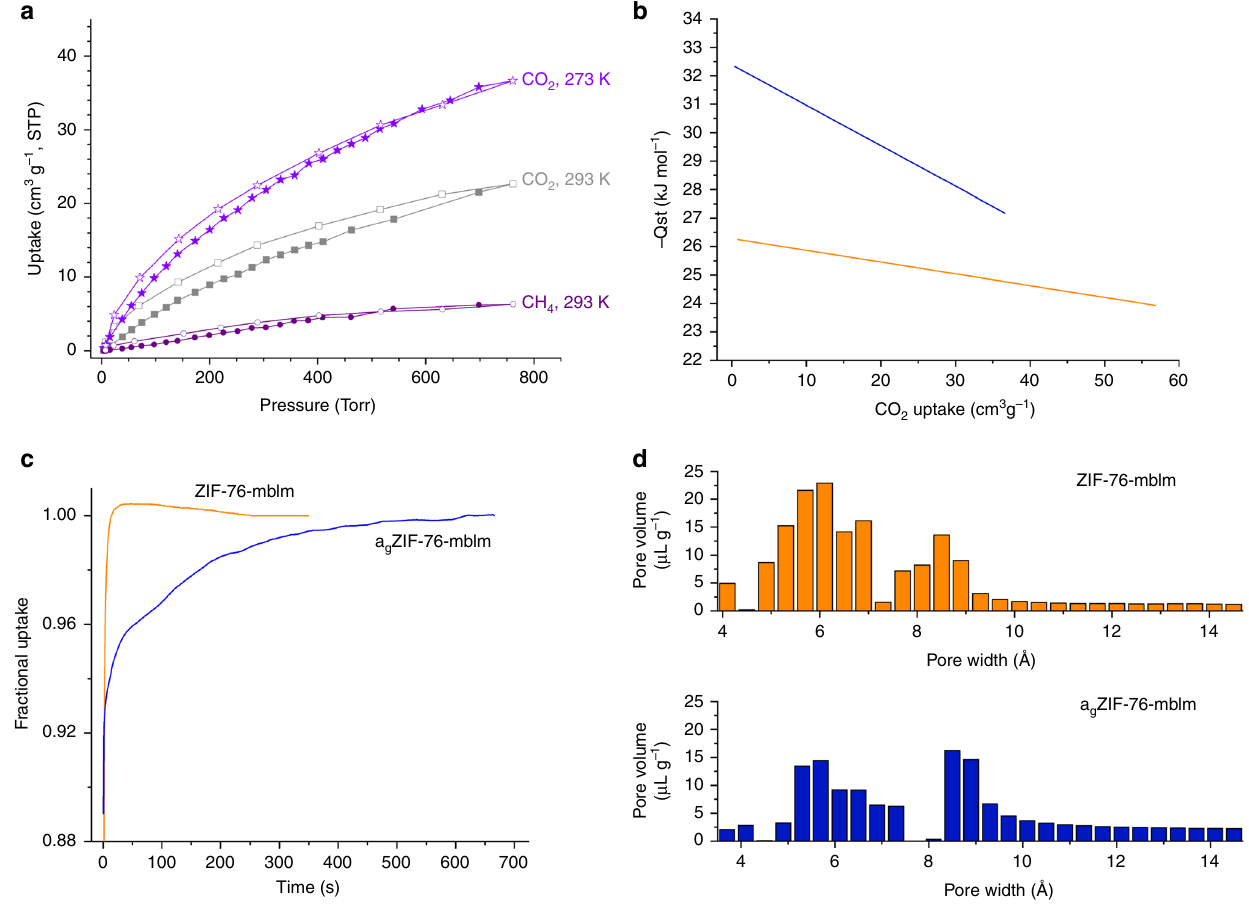
Fig. 4 Permanent accessible porosity in a g ZIF-76-mbIm and comparisons with ZIF-76-mbIm. a Adsorption isotherms of a g ZIF-76-mbIm ( fi lled symbols = adsorption, empty symbols = desorption). b Calculated isosteric heats of adsorption ( Q st ) for CO 2 as a function of guest loading, orange ZIF-76-mbIm, blue a g ZIF-76-mbIm. c Time-dependent CO 2 uptake pro fi les at 273 K at a pressure of 5 Torr. d Pore size distributions as determined by a NLDFT method from CO 2 adsorption isotherms at 273